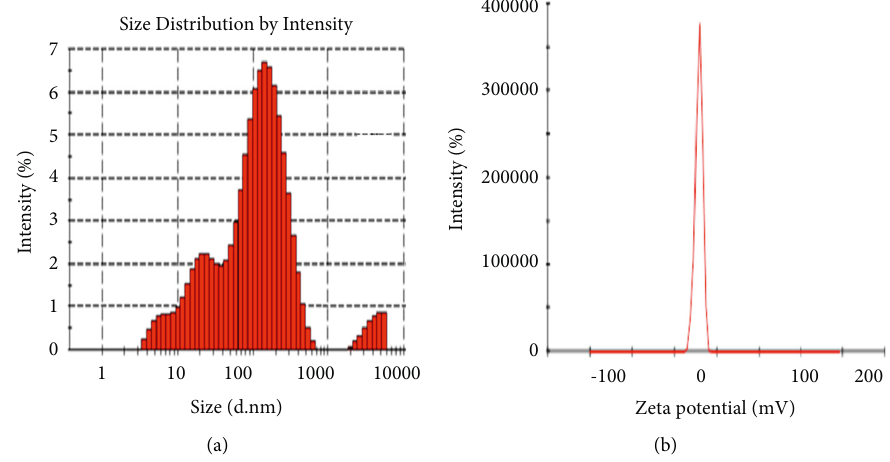
Figure 6: (a) DLS and (b) Zeta potential of synthesized Ag nanoparticle. Table 1: MIC values of nanoparticles using Escherichia Coli and Staphylococus aureus. Test organism